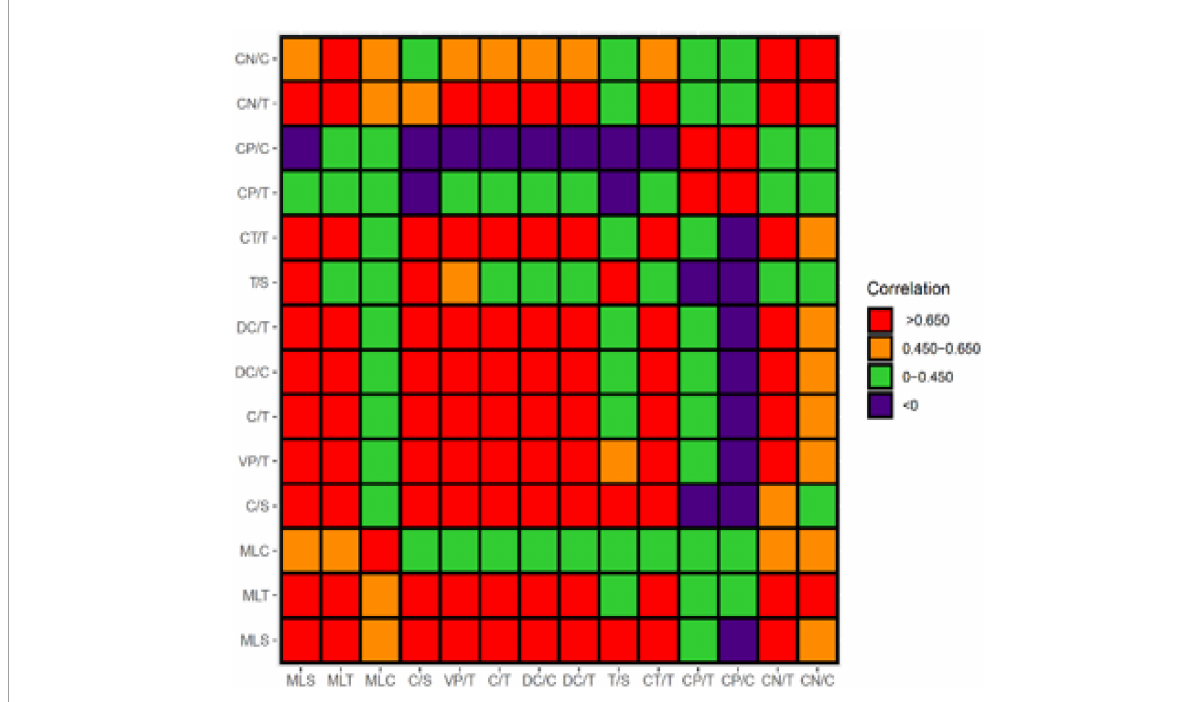
FIGURE2 Correlation among syntactic complexity indicators. According to Wolfe-Quintero et al. (1998), correlation greater than 0.650 is a strong correlation, 0.450–0.650 is a moderate correlation, and less than 0.450 is a weak